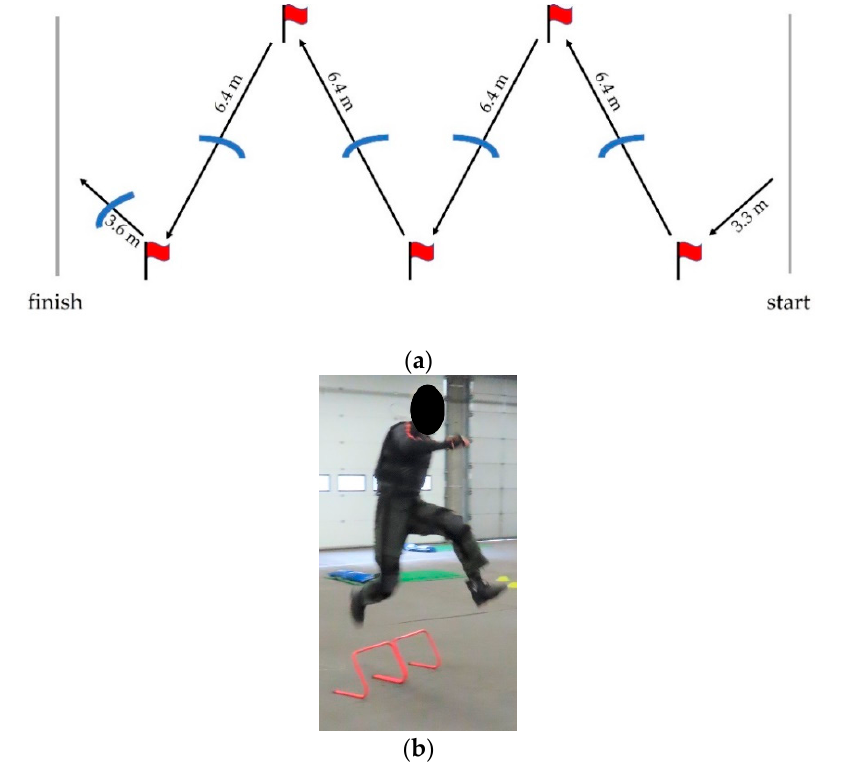
Figure 1. ( a ) Overview of the agility run with five flags and five (low) hurdles. The starting line is on the right side of the image and the finishing line on the left side. ( b ) Subject is jumping over one of the hurdle